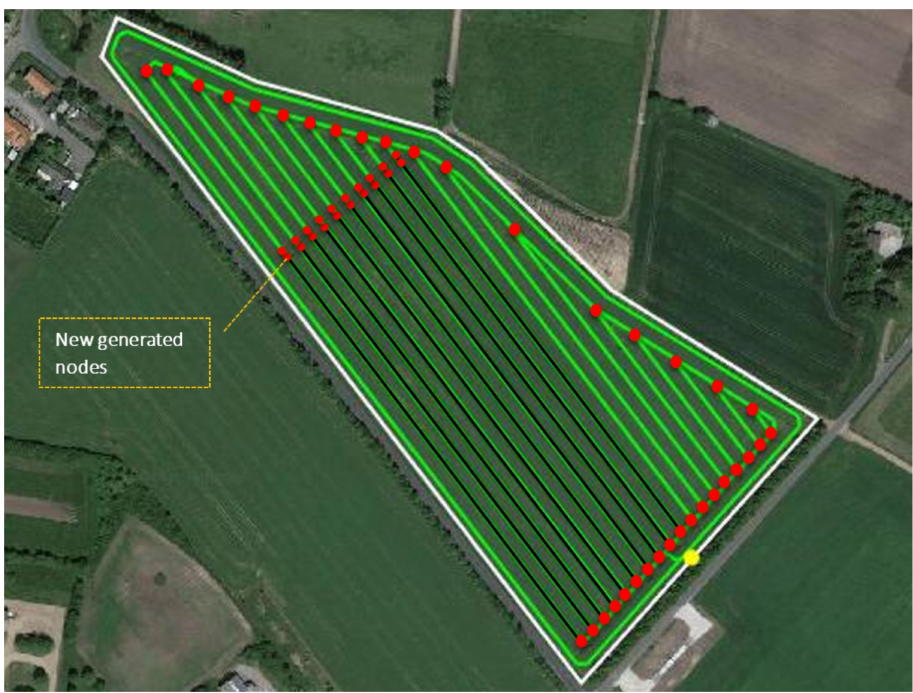
Figure 1. Division